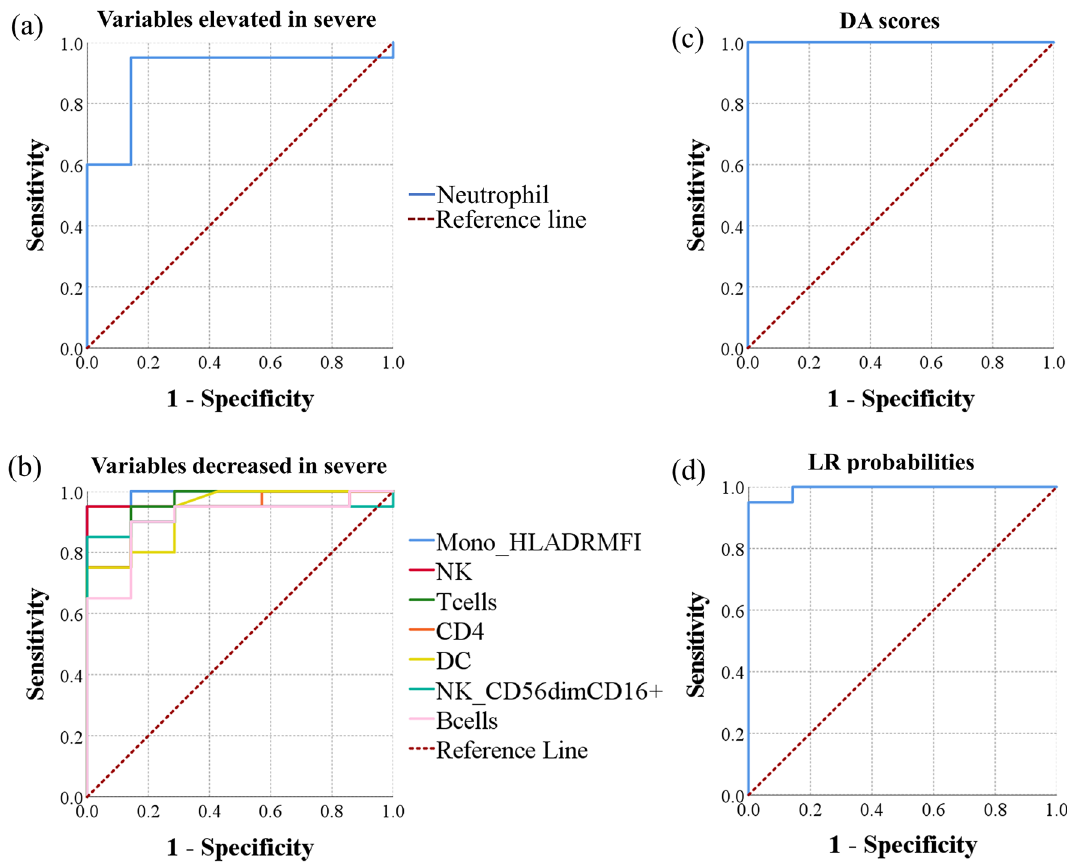
Figure 4. Evaluation of individual biomarkers, discriminant scores, and binary logistic regression probabilities as biomarkers of severe disease among admitted COVID-19 patients. ROC curves were generated using data from patients with moderate disease (n = 7) and patients with severe disease (n = 27). ROC curves of ( a ) individual analytes elevated in severe COVID-19, ( b ) individual analytes decreased in severe COVID-19, ( c ) discriminant function scores, and ( d ) probabilities of having severe disease computed using binary logistic regression are